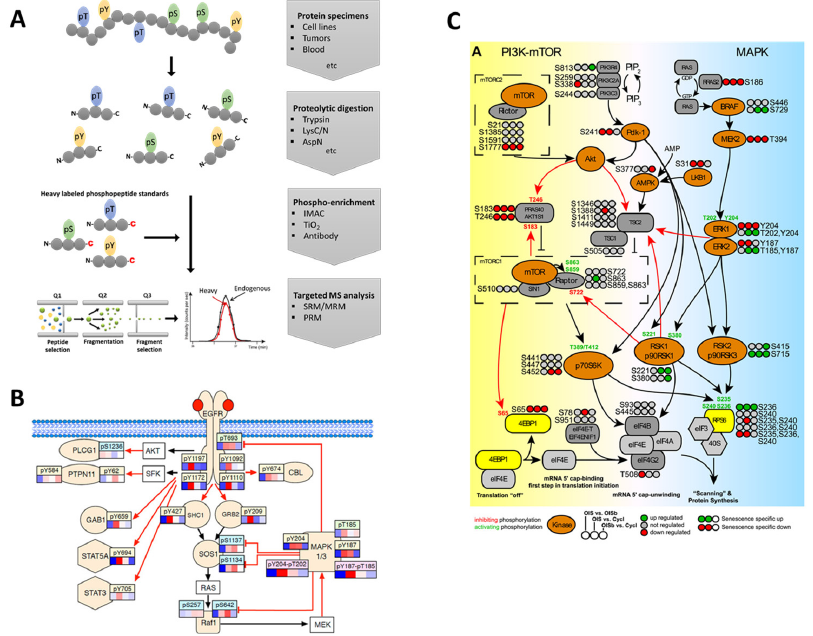
Figure 1. ( A ) Standard workflow for targeted analysis of protein phosphorylation. Selected studies have demonstrated the use of SRM to measure phosphorylation dynamics of signaling molecules complexes such as the ( B ) EGFR-MAPK pathway [53] and ( C ) PI3K-mTOR and MAPK pathway [54].